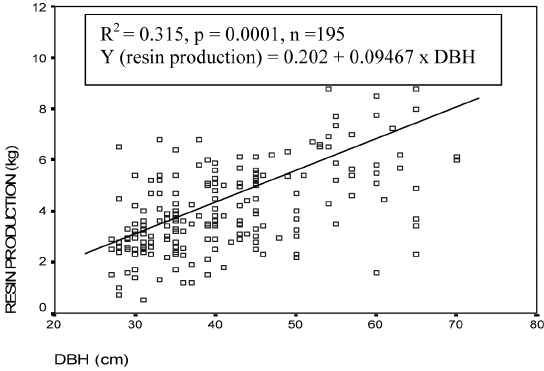
4. Linear regression of resin production (kg) and tree size expressed as DBH